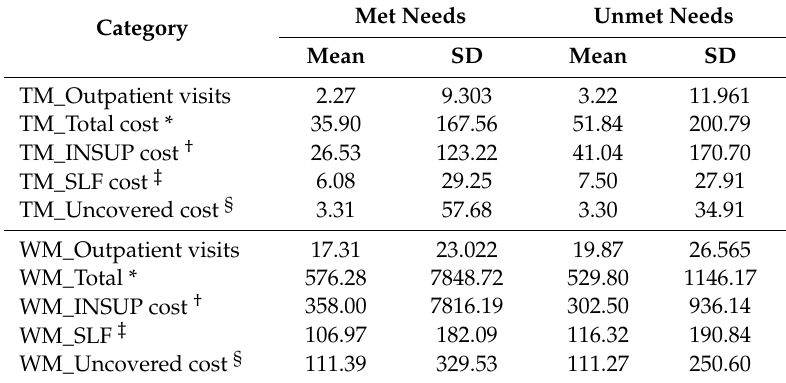
Table A1. Medical costs of participants with unmet needs and those with met needs according to type of medical care.